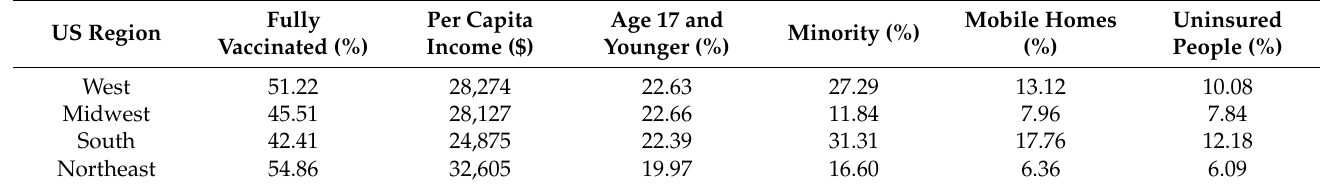
Figure 1. Boxplots of the response variable and covariates used in the models. Table 2. Mean values of the response variable and covariates used in the models classified based on regions in the United States as of 29 July 2021.